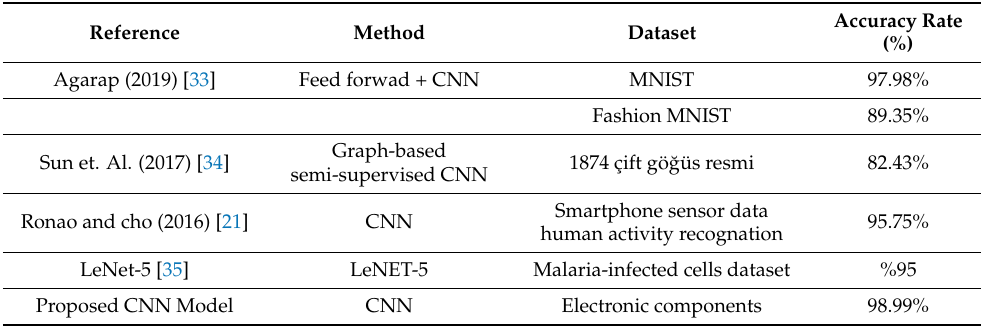
Table 8. CNN models performance results.